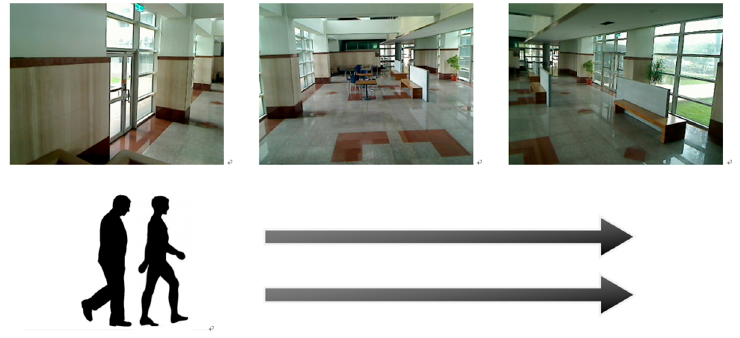
Figure 19. Two persons tracking in overlapping scene.